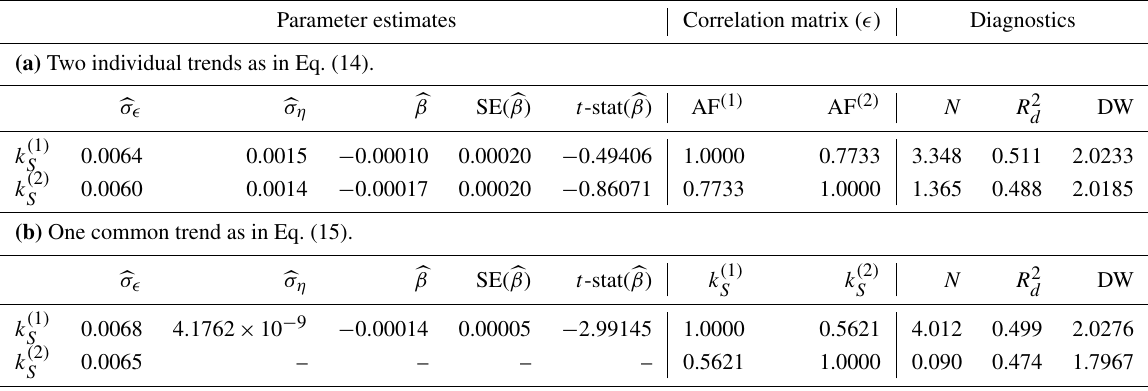
Table 4. Multivariate analysis of the CO 2 sink